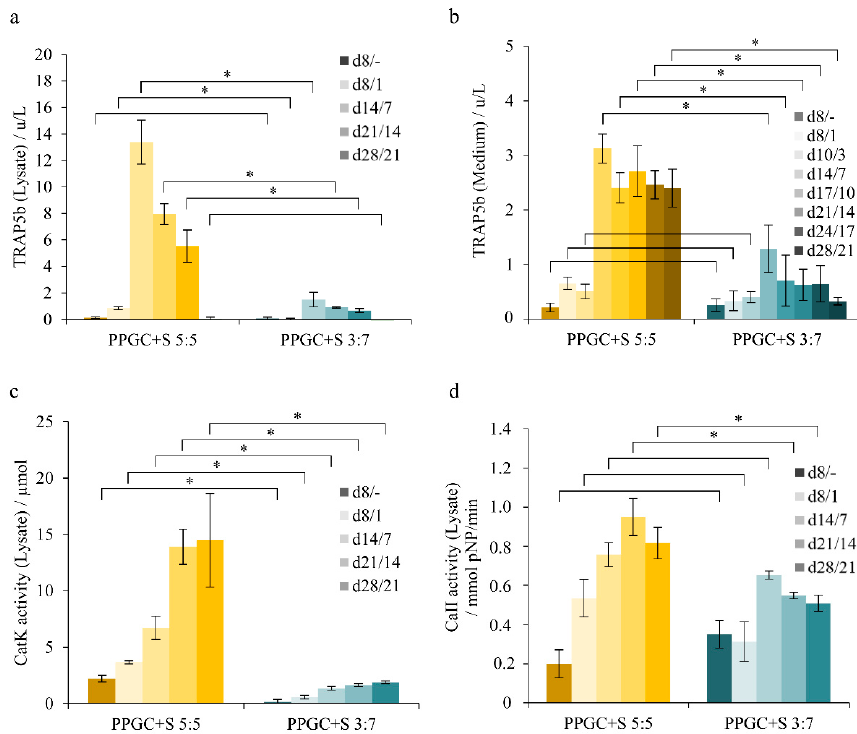
Figure 4. Osteoclastic di ff erentiation of human mononuclear cells (hMc) to osteoclasts during co-cultivation with osteoblasts in vitro. The first number in the legend refers to the duration of the precultivated HMSC and the time required for di ff erentiation to osteoblasts. The second number refers to the time of human monocytes cultivation seeded on day 7 to the osteoblasts, giving the time of co-cultivation. Intracellular tartrate-resistant acid phosphatase isoenzyme 5b (TRAP5b) ( a ) as well as extracellular TRAP5b expressed into the medium ( b ) as an early marker of osteoclastogenesis and cathepsin K (CatK) activity ( c ) and carbonic anhydrase II (CaII) activity ( d ) as an indicator for osteoclastic resorption. Asterisks indicate statistical significant di ff erences ( p < 0.05).